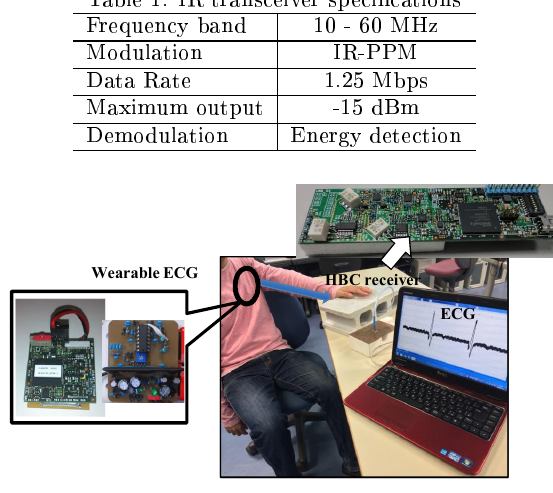
Figure 2: View of veri(cid:28)cation experiment.